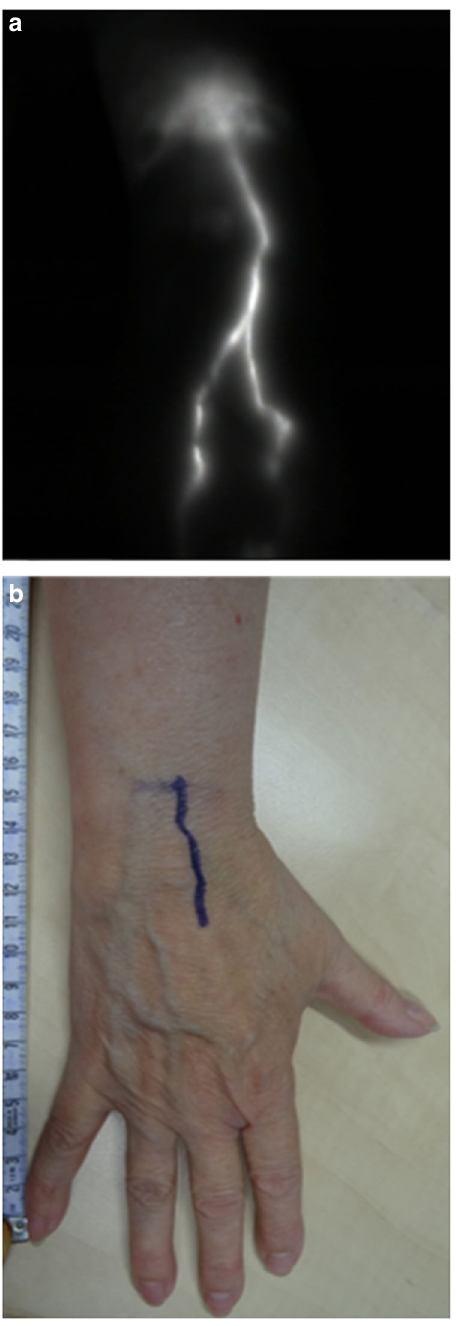
Fig. 3 Preoperative NIRF lymphography and corresponding markings. a An example of preoperative NIRF lymphography after intradermal ICG administration in the second and fourth fi nger web spaces of the right hand of a study subject, as performed in the lymphedema outpatient clinic. b Corresponding preoperative markings based on fi ndings of NIRF lymphography in the same patient. Measuring tape is used to indicate the site for incision during the actual LVA Study parameters . The following patient characteristics were obtained: age, BMI, ISL stage, smoking status at baseline, daily use of compression garment, and manual lymph drainage at baseline, one month and three months post surgery. Primary outcome regarding the surgical procedure was quality of the anastomosis. Secondary outcomes included duration of the surgery, problems or technical errors during the procedure, postoperative complications and adverse events, Lymph-ICF total score (i.e., patient ’ s QoL), and UEL index of the affected arm (i.e., arm volume), surgeons ’ satisfaction and patient ’ s satisfaction with respect to the